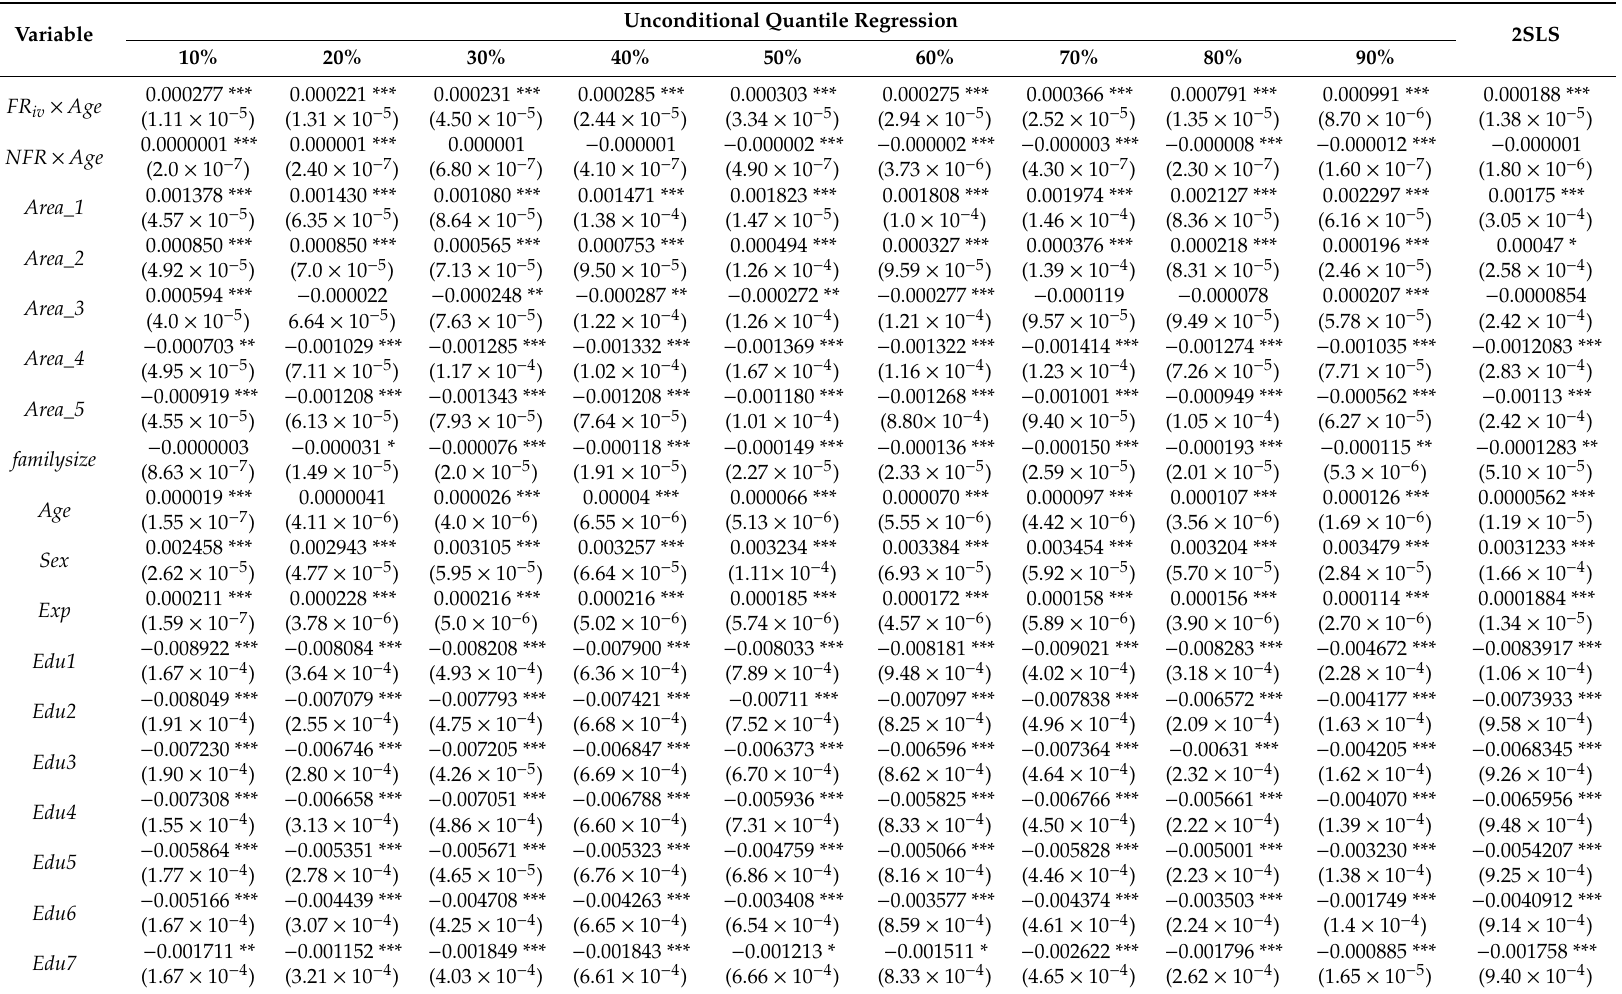
Table 3. Empirical results from two-stage least squares (2SLS) and unconditional quantile hedonic wage regressions (dependent variable: BC_hour_wage.).